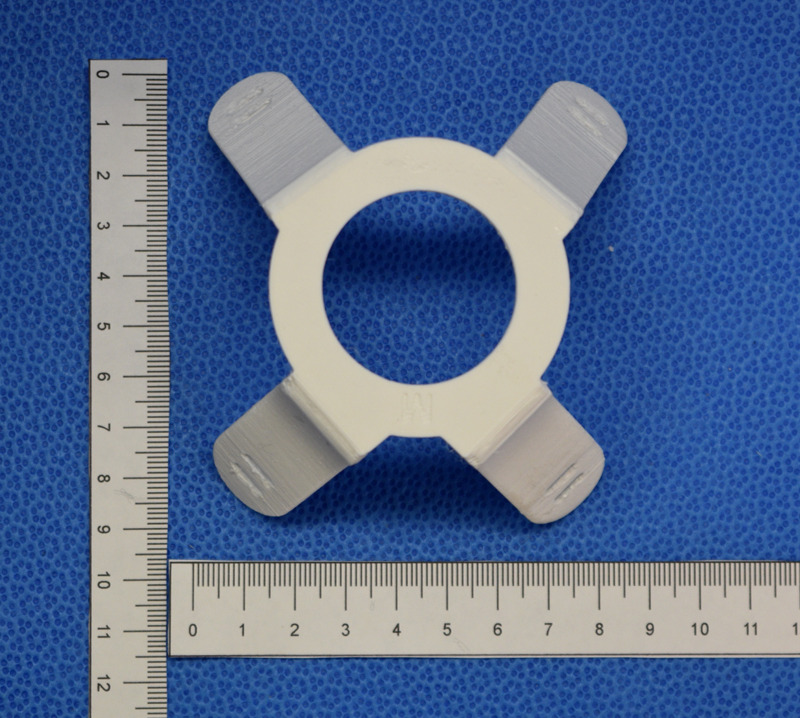
3D printed harness using PET-G plastic on the Prusa-MK3.